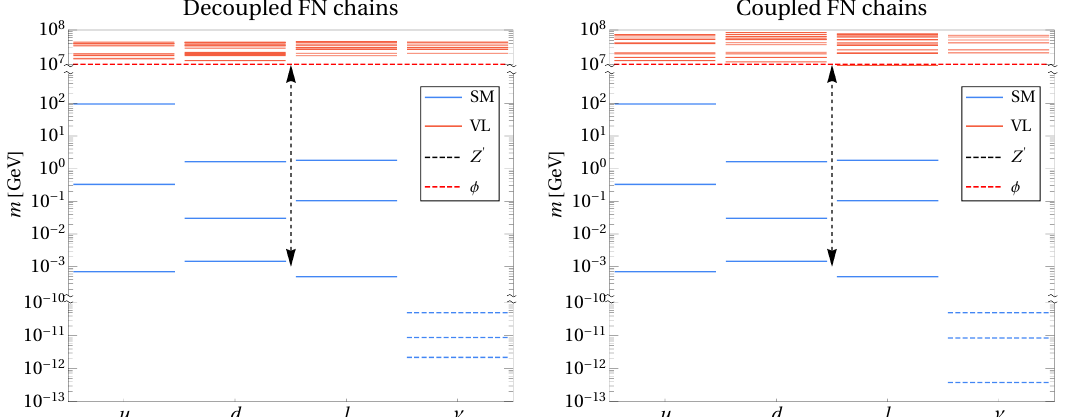
Figure 1 . Mass spectra for G FN = U(1) 3 (left) and G FN = U(1) models (right), with masses of vector-like masses denoted in red, of SM fermions in blue and the considered range of Z 0 masses denoted with a dashed line. The spectra correspond to the two benchmarks considered in section 5 and appendix B. The (cid:13)avon mass (dashed red) is not (cid:12)xed in the two benchmarks, but is set to 10 7 GeV in the two panels, indicative of its typical